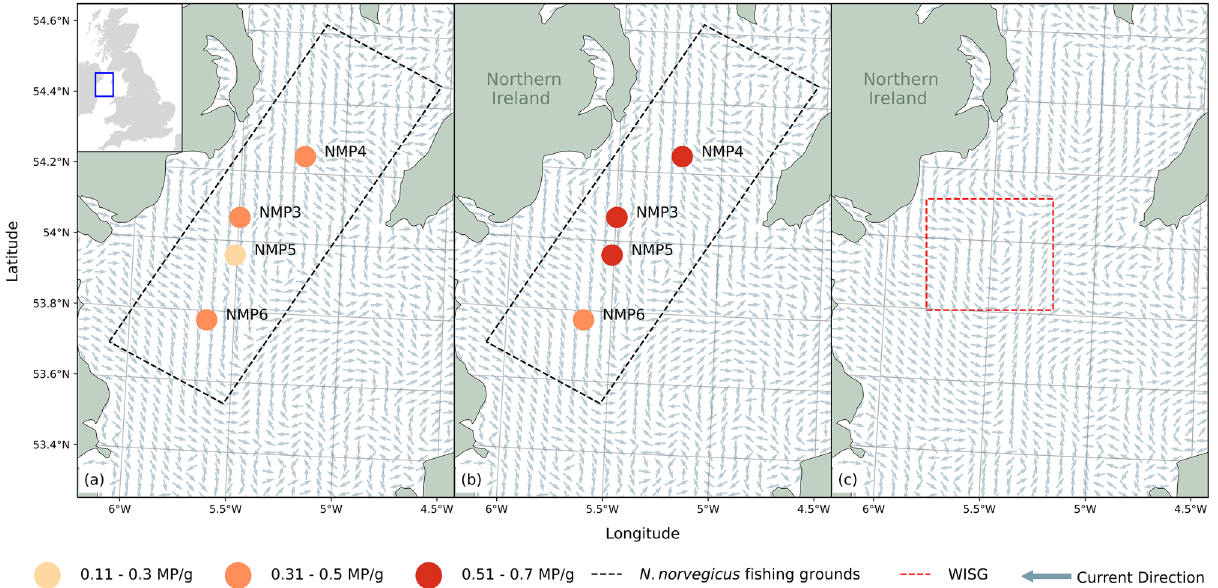
Figure 1. The location, site ID and mean microplastics per gram (MP/g) found within the four sediment sampling sites from the Western Irish Sea fishing grounds in ( a ) January 2016 and ( b ) January 2019. Monthly modelled residual currents for January 2020 ( a , b ) and July 2020 ( c ) demonstrating the development of the WISG in early summer. Modelled current data from E.U. Copernicus Marine Service Information 25